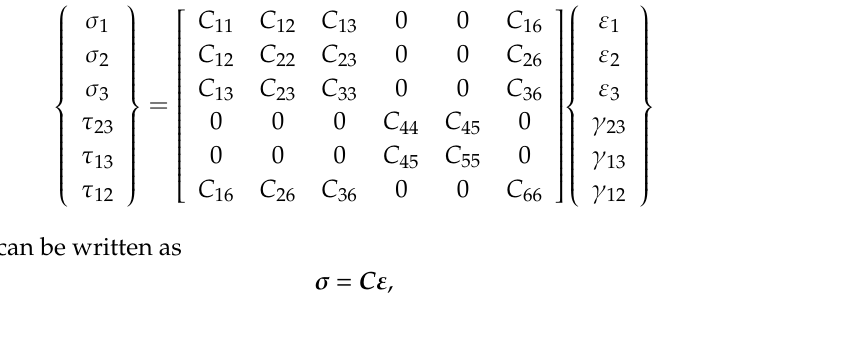
Table 2. Bending experiment data of the composite sandwich laminated box beams.